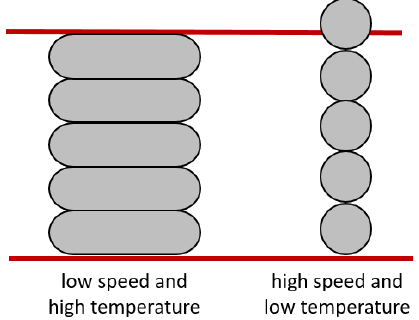
Figure 10. E ff ect of printing temperature and printing speed on the dimensional accuracy in the Z direction.